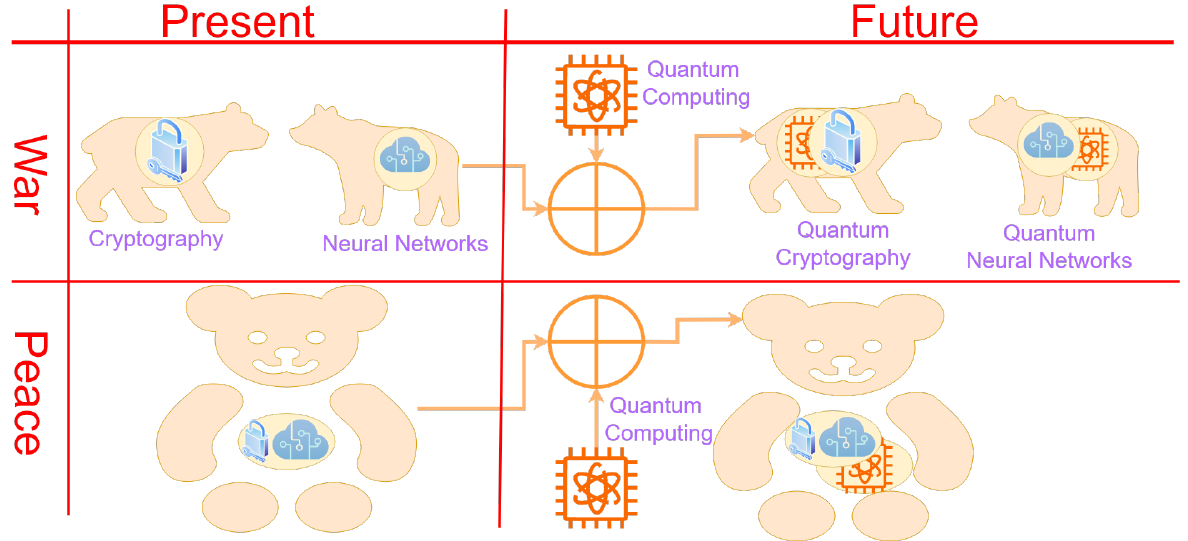
Figure 3. The future of the neural network–cryptography